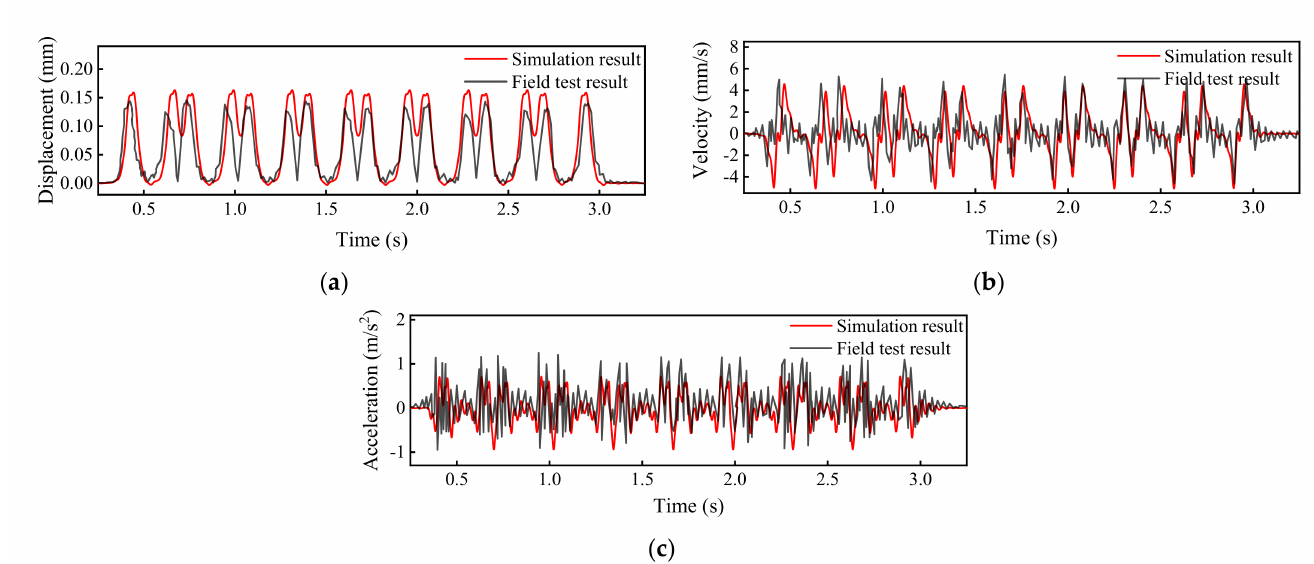
Figure 7. Comparisons of field-measured and model-calculated dynamic responses of the top embankment layer: ( a ) Vertical displacement; ( b ) vertical velocity; and ( c ) vertical acceleration.